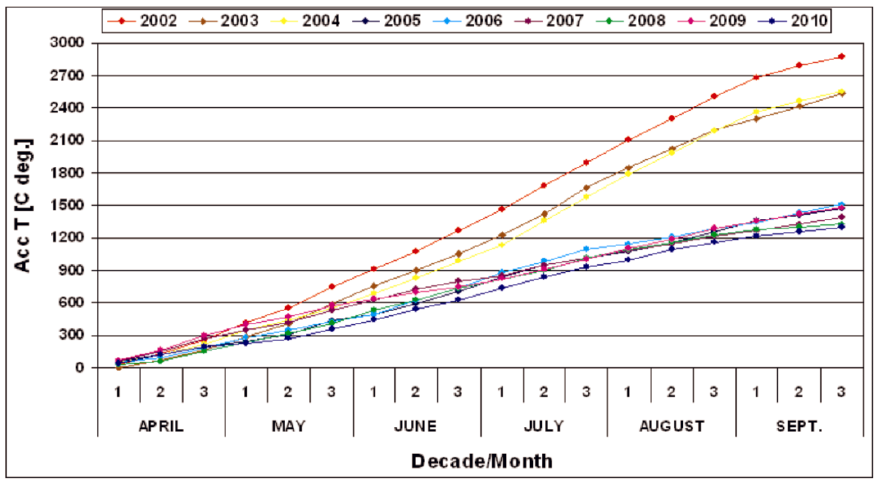
Figure 2. Accumulated values of air temperature (Acc T).